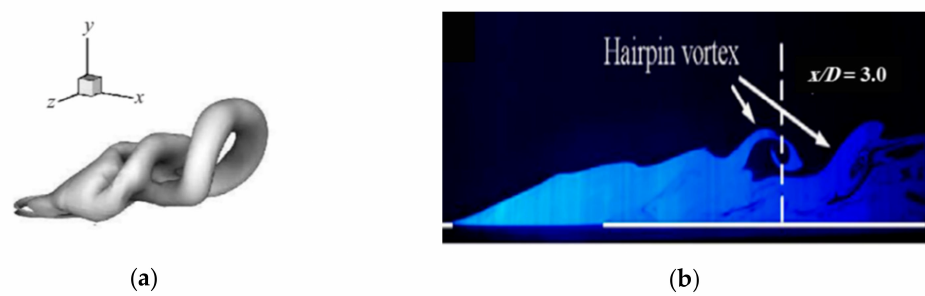
Figure 12. Hairpin vortices visualization: ( a ) hairpin structure for a JICF at r = 1.0 taken from Sau and Mahesh [96]; and ( b ) instantaneous LIF visualization of hairpin structure at r = 0.5 taken from Dai et al.